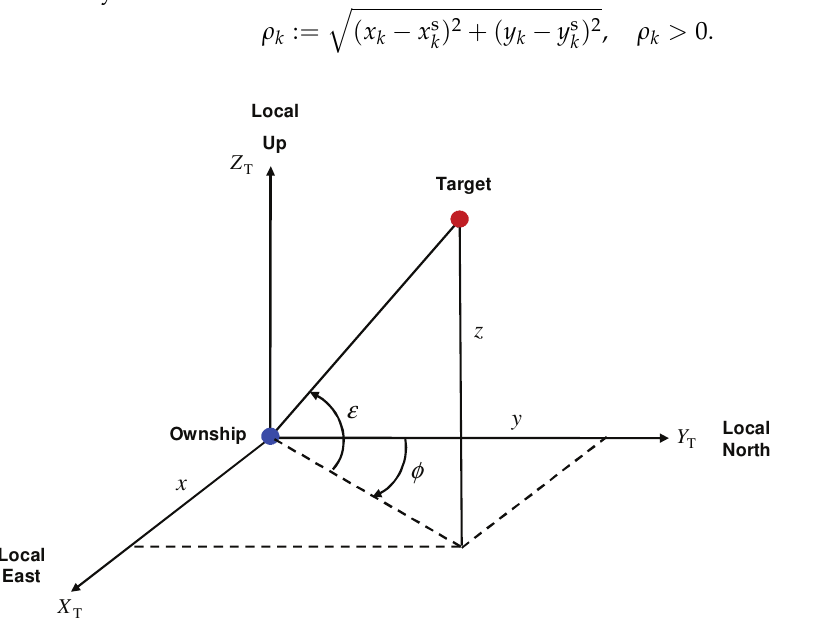
Figure 2. Definition of the tracker coordinate frame (T frame), bearing φ ∈ [ 0,2 π ) and elevation (cid:101) ∈ ( − π /2, π /2 ) .